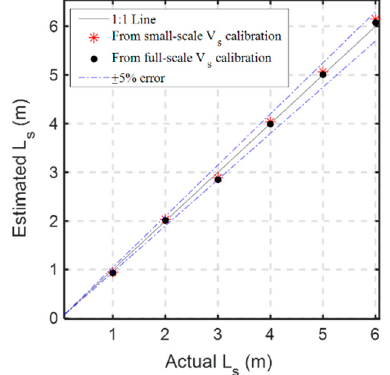
Figure 13. Estimated L s in the full-scale experiments based on different calibrated vs. in Figure 12.